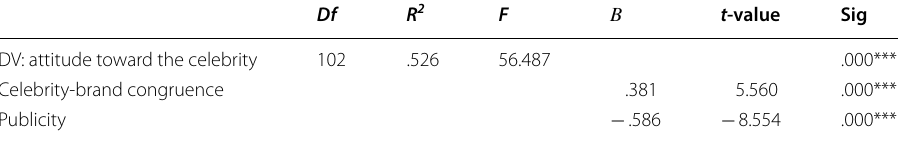
Table 4 Celebrity-brand congruence/publicity and attitude toward the brand